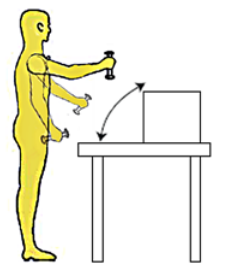
Figure 5. Lifting and lowering